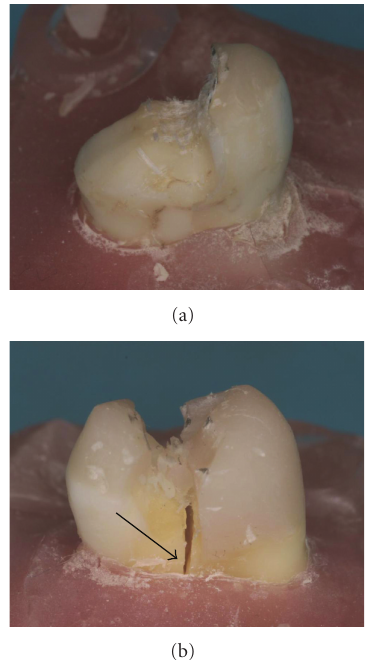
Figure 4: Examples of repaired specimens with woven FRC basing after the load test; fracture along the repaired surface (a) and vertical root fracture, indicated by the arrow